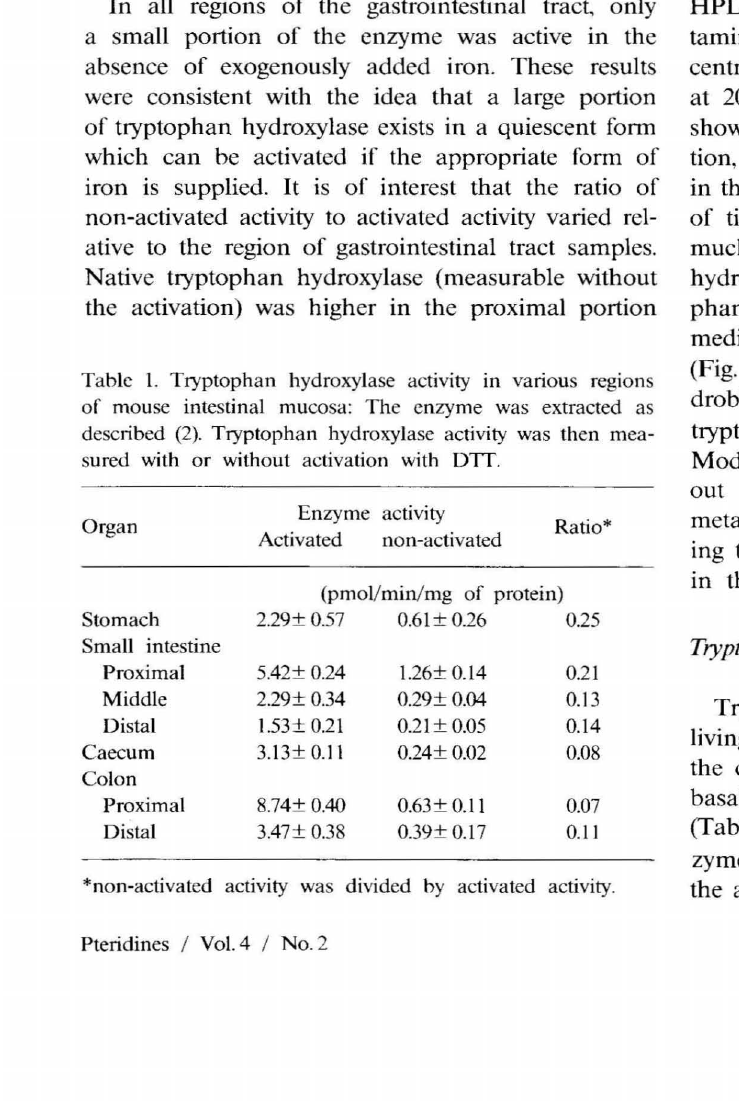
*non-activated activity was divided by activated activity. Pteridines / Vol.4 / No.2